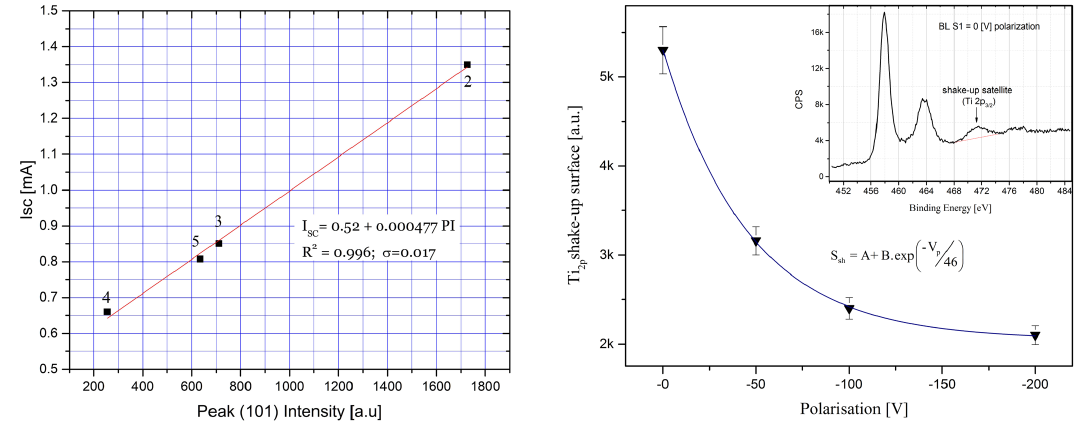
Figure 8. Correlation between the cell short current I Anatase (101) peak intensity.